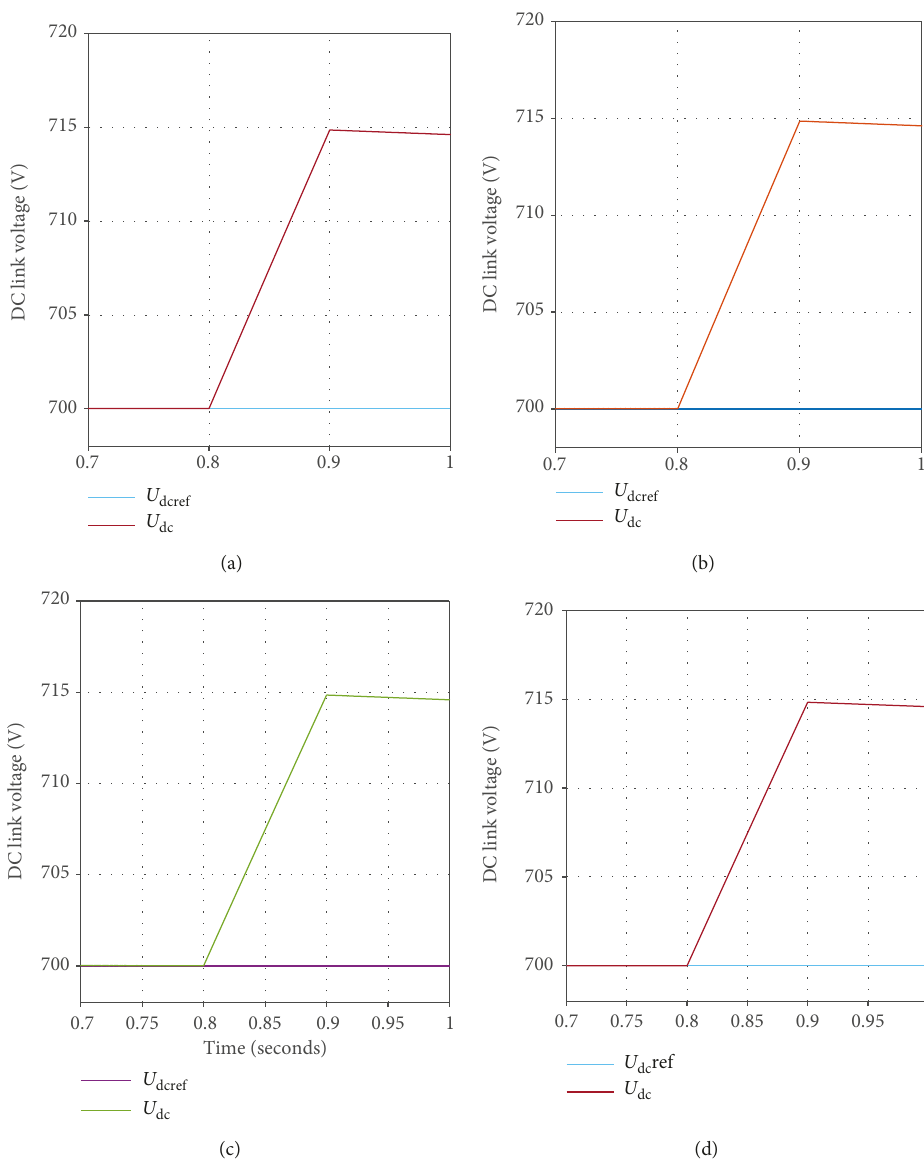
Figure 19: Voltage dip e ff ect on DC link voltage with limitation by using (a) PSO-PID; (b) GA-FOPID; (c) ACO-PID; (d) TLBO-FOPID.